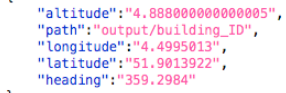
Figure 4 - Portion of the JSON map containing the references to the glTF model and coordinates for geo-referencing the object